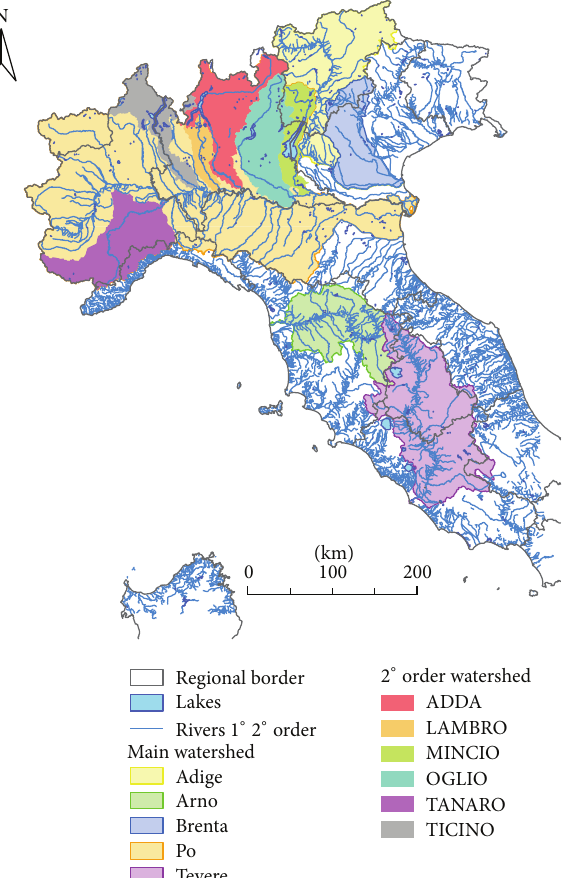
Figure 1: Watersheds of the first and second order rivers which were